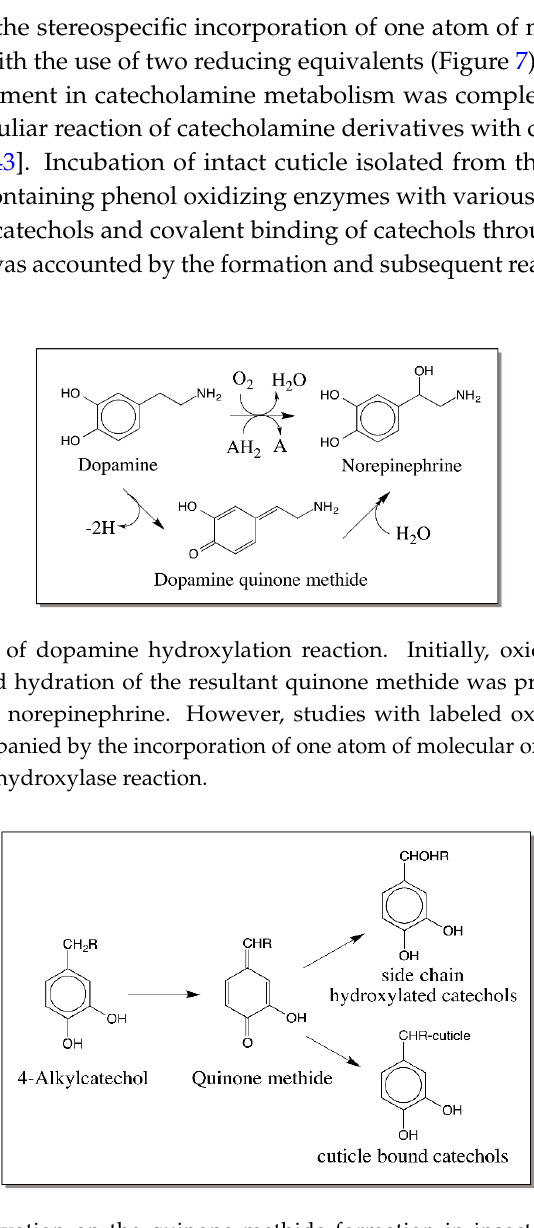
Figure 8. Initial observation on the quinone methide formation in insect cuticle. Incubation of 4-alkylcatechols with intact cuticle resulted in the covalent binding of catechols through their side chain to the cuticle and generation of side chain hydroxylated products.